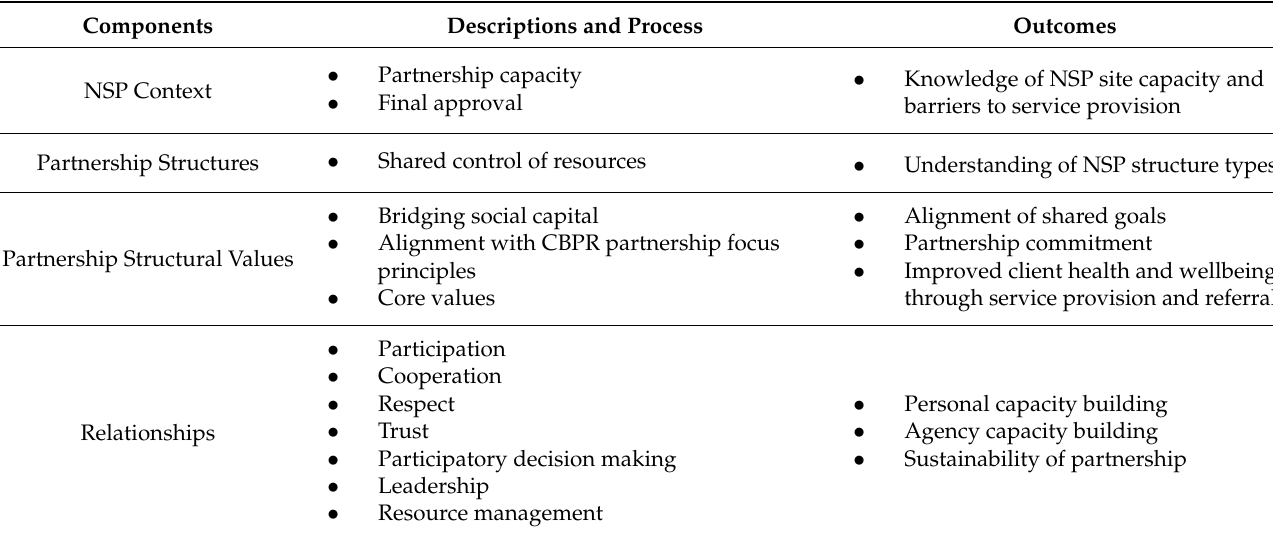
Table 1. Components of the collaborative community—academic